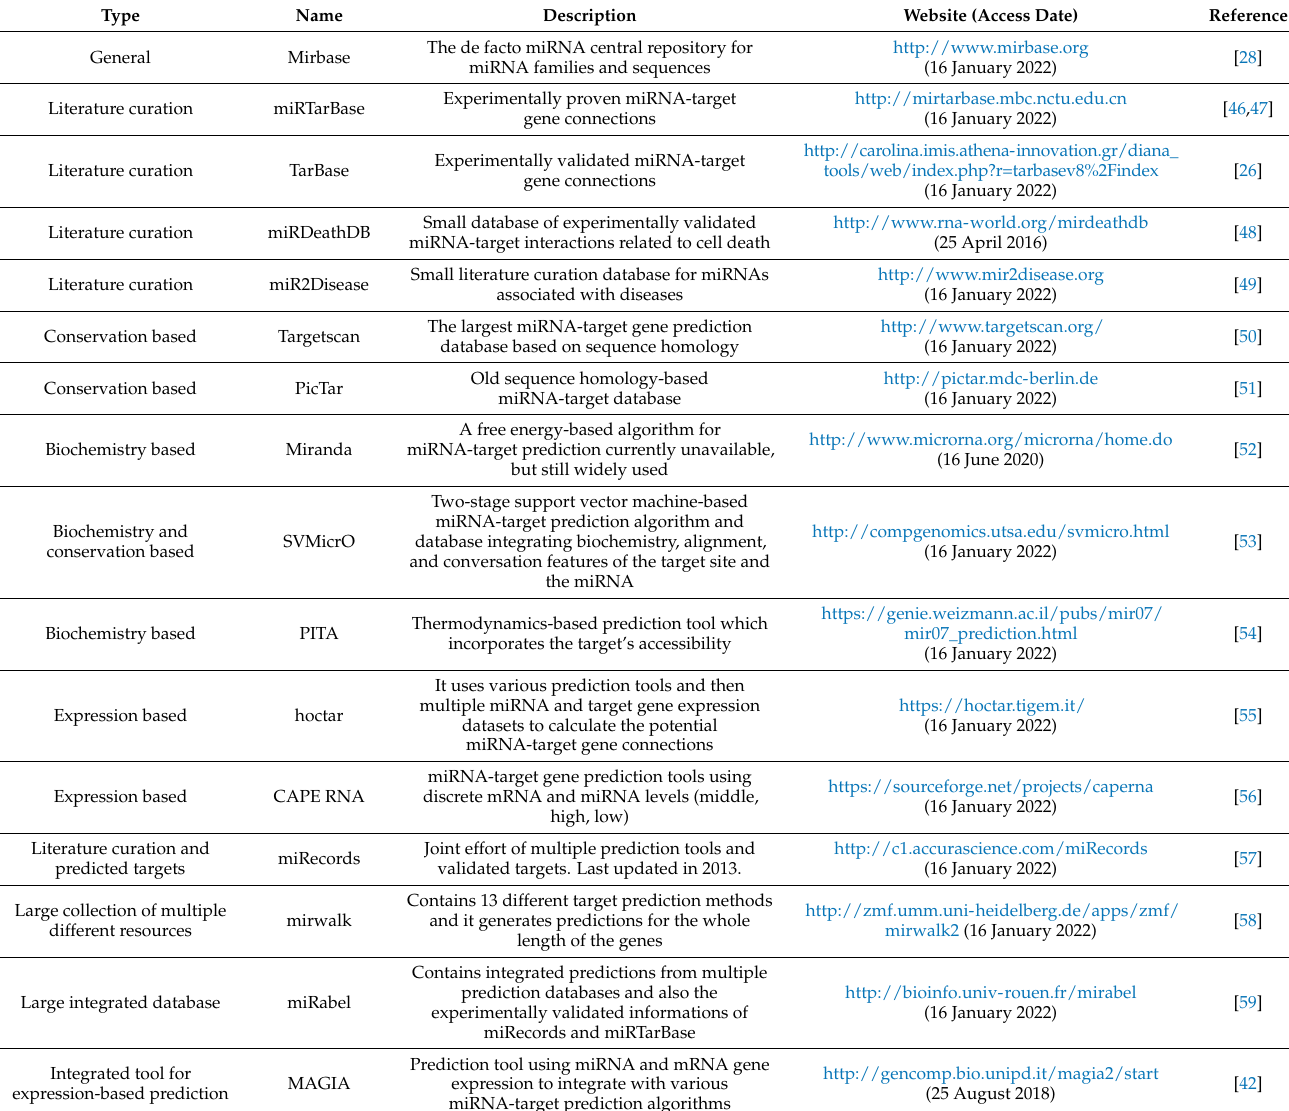
Table 1. Various miRNA—target gene databases and